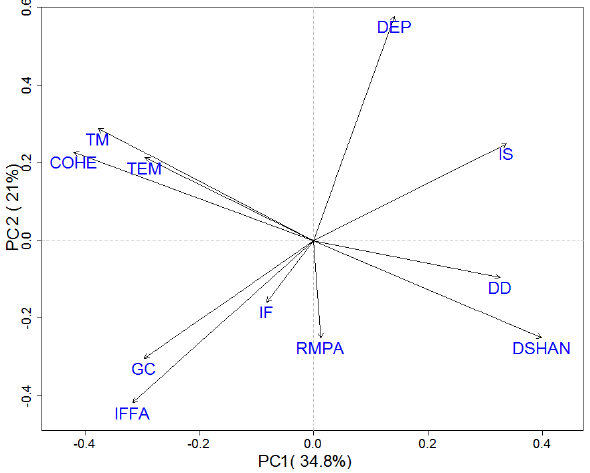
Figure 3. Spatial distribution of the principal component loadings of the FI 2006 at FUA level, after the correlation